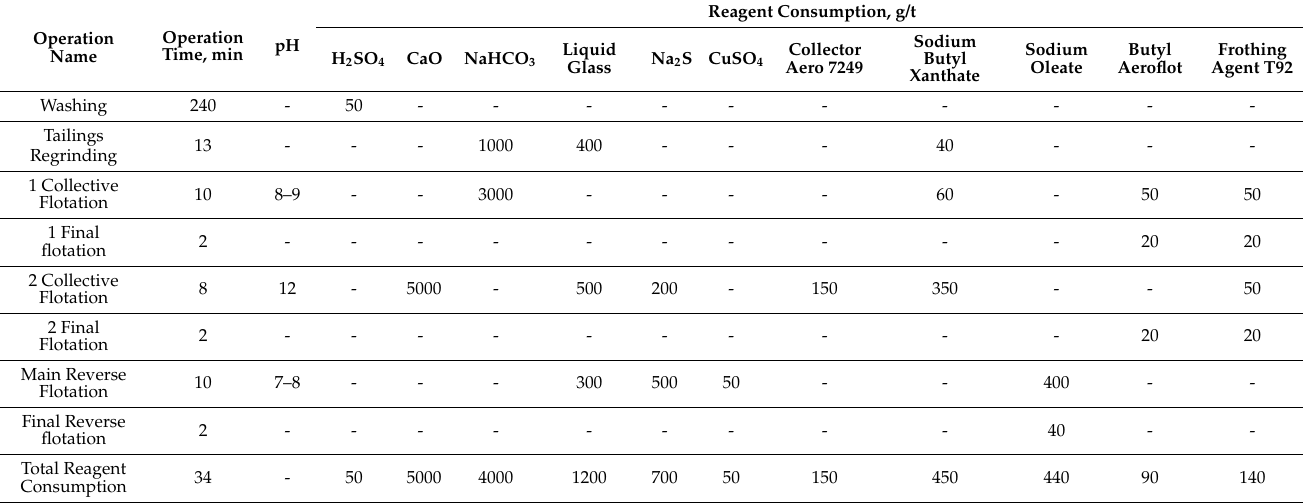
Table 7. Reagents consumption for tailings processing.